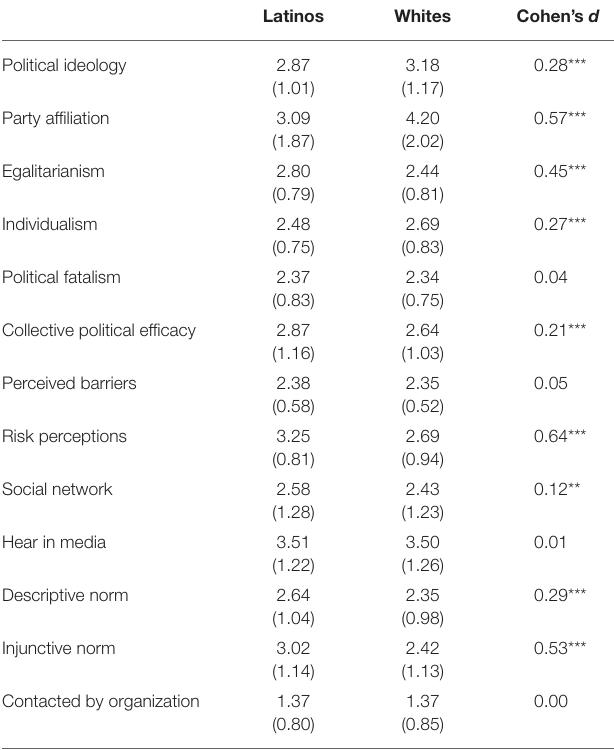
TABLE 3 | Means and standard deviations of predictors by Latinos and